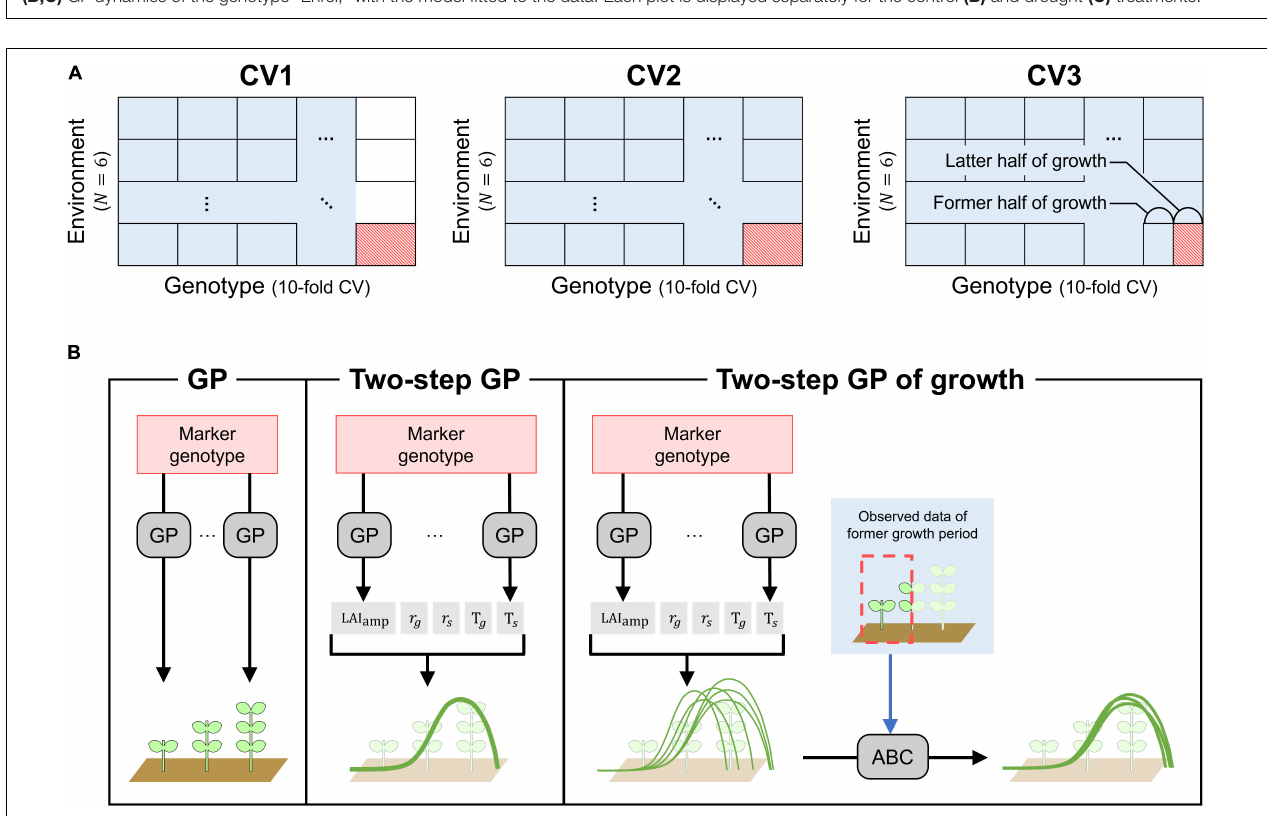
FIGURE 2 | (A) An example of LAI dynamics described with the model (Equation 2). The parameters of the LAI dynamics model are displayed to visualize their roles. (B,C) GF dynamics of the genotype “Enrei,” with the model fitted to the data. Each plot is displayed separately for the control (B) and drought (C) treatments.